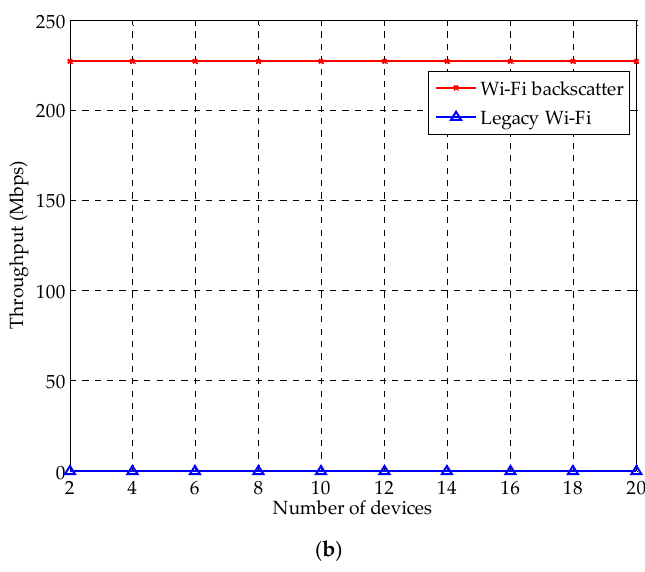
Figure 9. Variation of throughput for burst transmission: ( a ) SIFS between consecutive packets without MAC configurations for initial channel access; and ( b ) all of the MAC configurations.